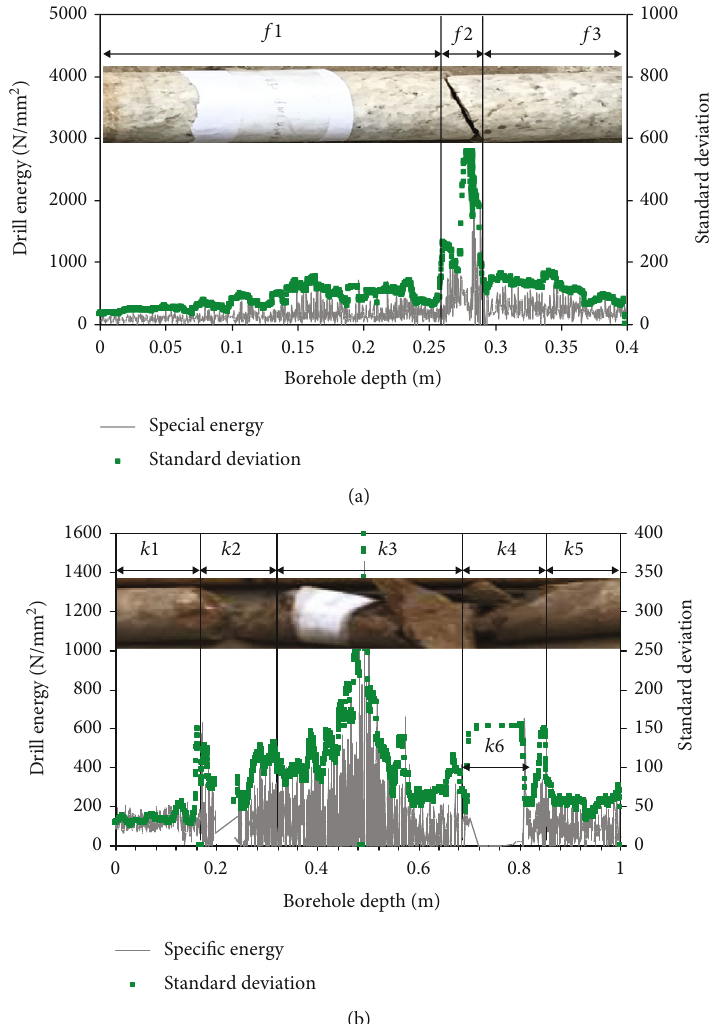
Figure 3: The distributions of fracture, speci fi c energy, and standard deviation in each length range. (a) The core log, drilling energy, and standard deviation of drilling energy from the depths of 0 to 0.4m in marble. Drilling energy and standard deviation correspond to a single fracture in marble was observed at the depth of 0.265 ~ 0.283m. (b) The core log, drilling energy, and standard deviation of drilling energy from the depths of 0 to 1m in limestone. Drilling energy and standard deviation correspond to fracture zones in limestone were observed at the depth of 0.0.185 ~ 0.831